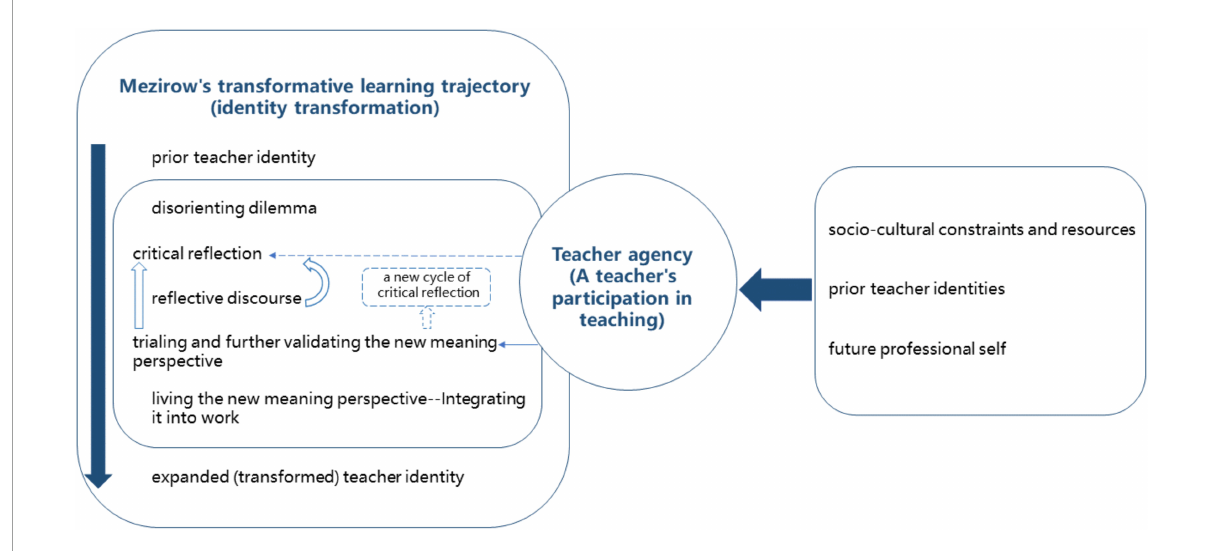
FIGURE1 The cognitive trajectory of Qing’s teacher identity transformation, achievement of her teacher agency and connection between these two